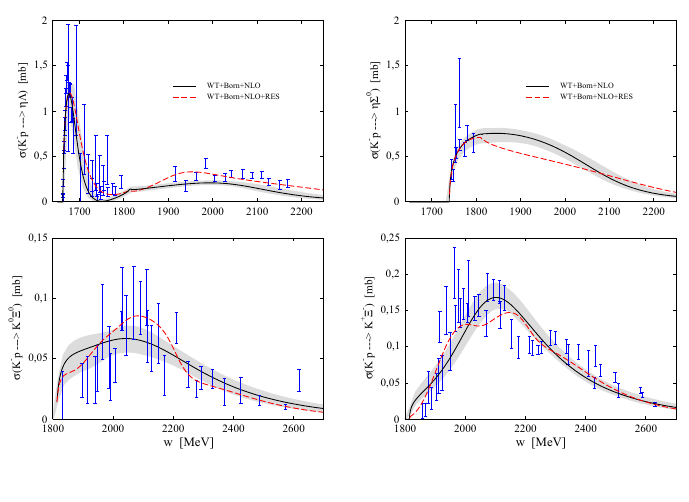
Figure 1. K − p → η Λ ,η Σ 0 , K + Ξ − , K 0 Ξ 0 total cross sections for the WT + Born + NLO fit, with its error bands (gray area) estimated as specified in [5], and for the WT + Born + NLO + RES fit. Experimental data has been taken from